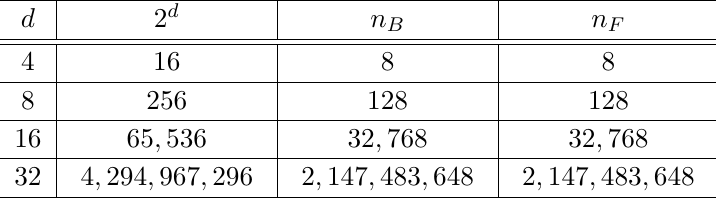
Table 2. Number of Independent Components in Unconstrained Scalar